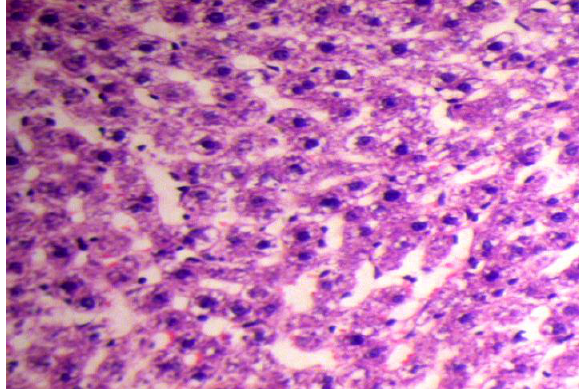
Fig. 3. Rat liver after ethanol administration. Diffuse small droplet of vacuoles in hepatocytes, inflammatory reaction and cell necrosis is absent. Hematoxylin-eosin.